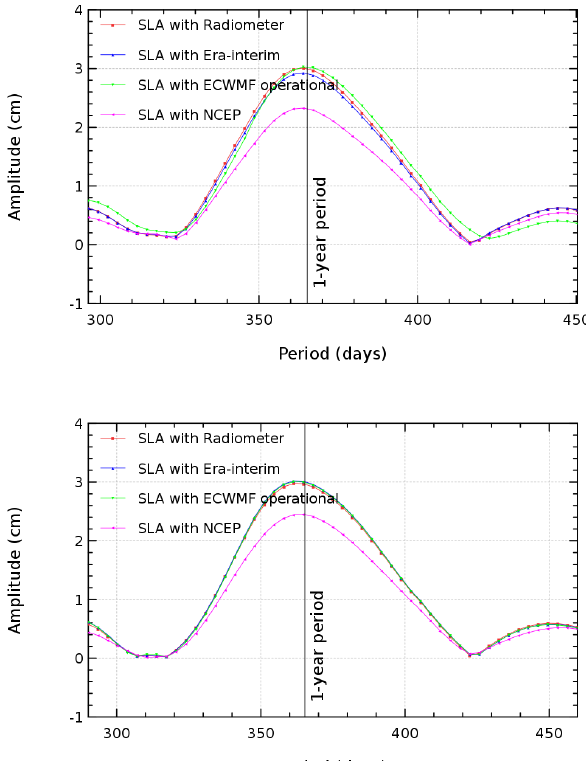
Figure 6. Amplitude of the annual signal (in cm) of the global altimeter mean sea level derived with different wet troposphere corrections over the first (top, T/P data) and the second (bottom, Jason-1 data) altimetry decade.